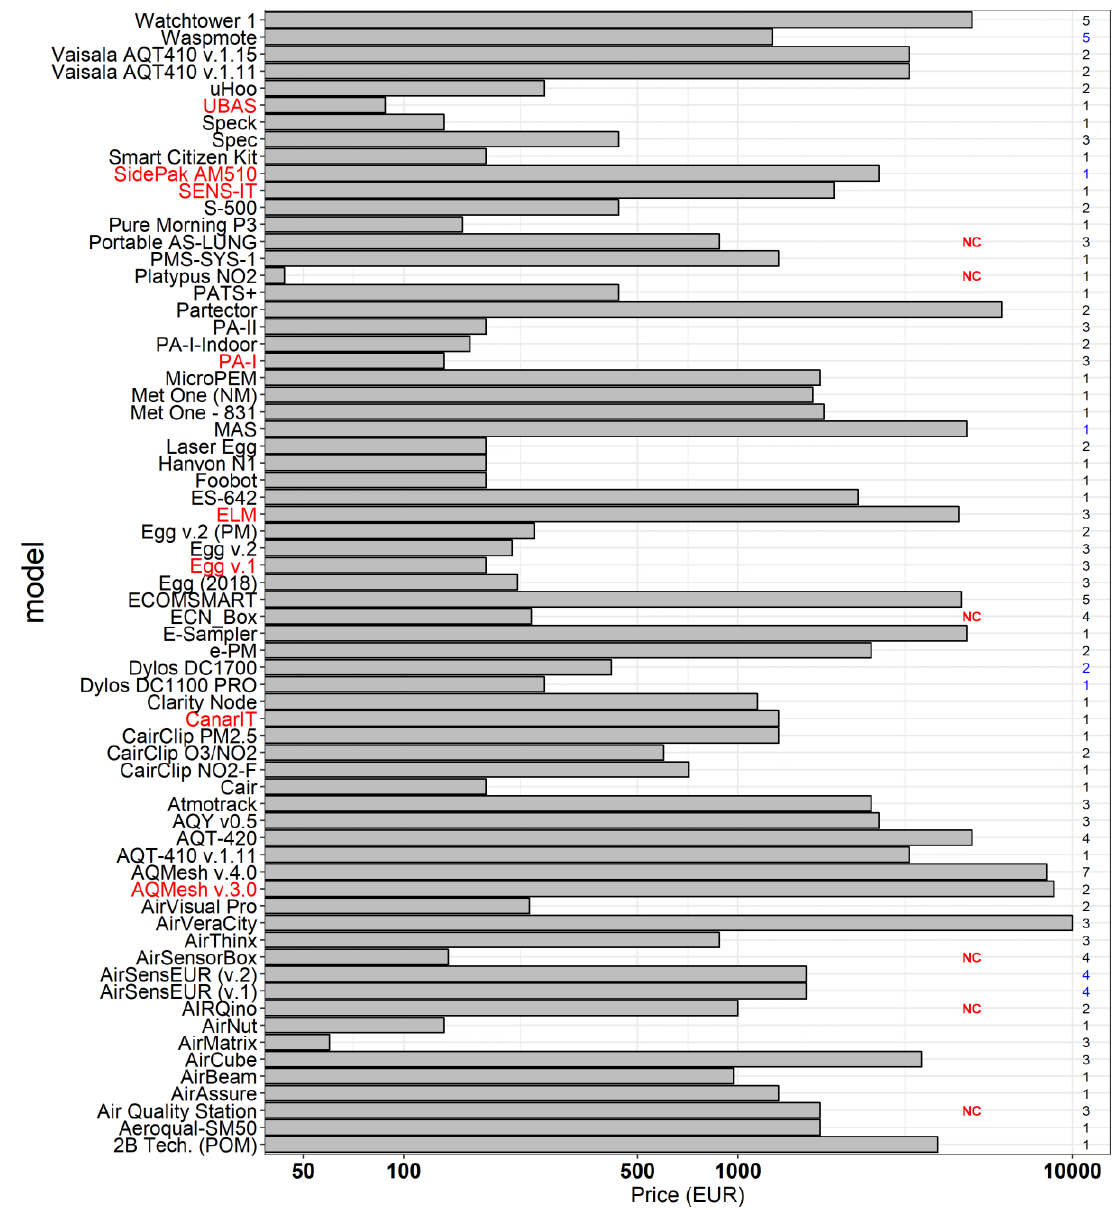
Figure 5. Prices of SSys grouped by model. Numbers on the right indicate the number of pollutants measured by each SSys, with open source in blue and black box in black. The x-axis uses a logarithmic scale. Names of “living” and “non-living” SSys are indicated in black and red colors on the labels of the y-axis, respectively. NC indicates commercially unavailable sensors.